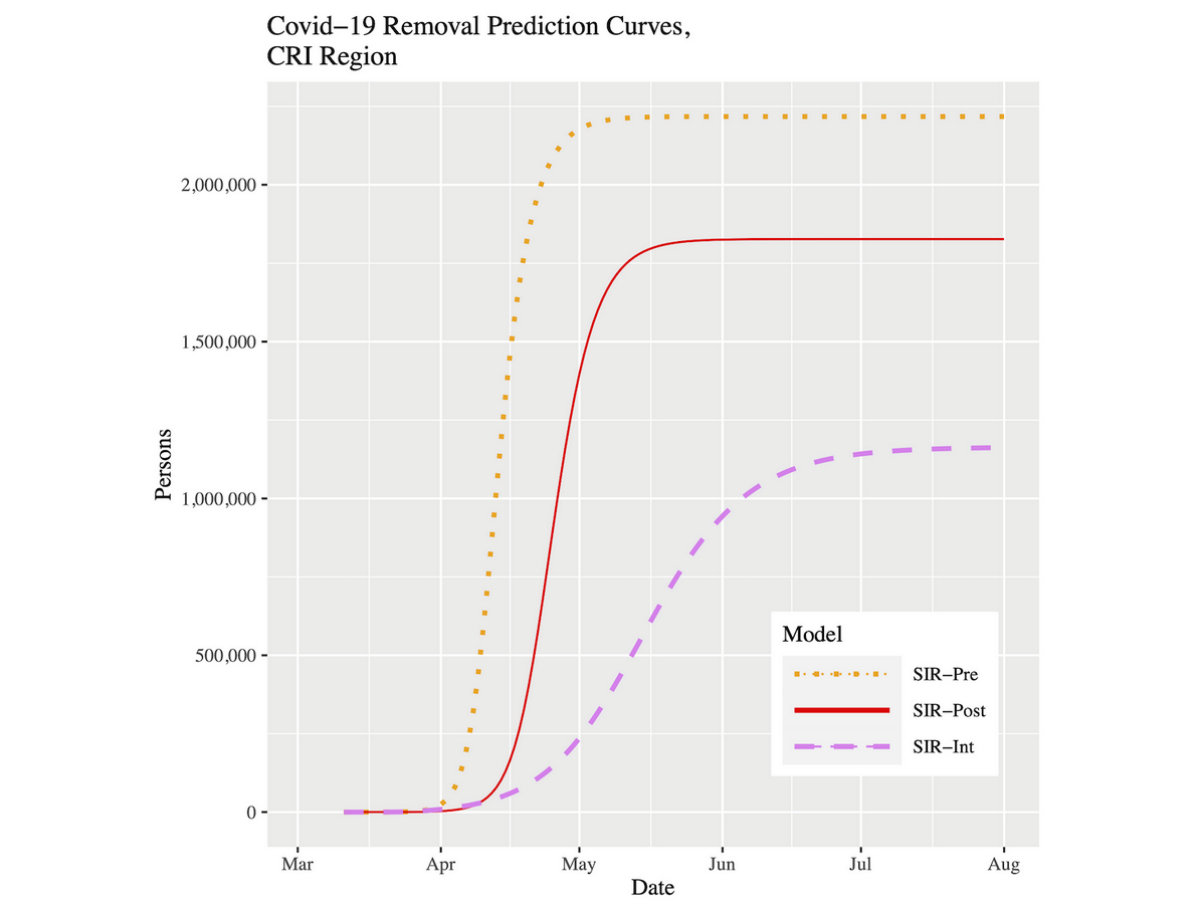
Figure 10. Removal prevalence prediction curves for the CRI up to August 1, 2020. COVID-19: coronavirus disease; CRI: Cities Readiness Initiative; SRI: